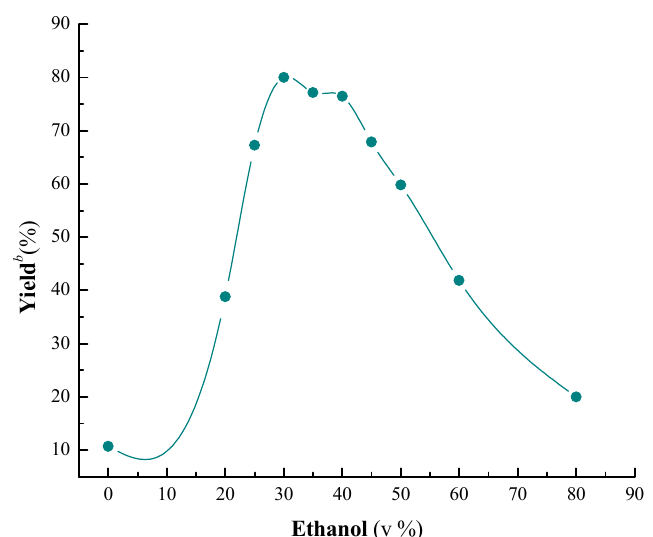
Figure 1. Influence of the ethanol content on the cascade reaction a